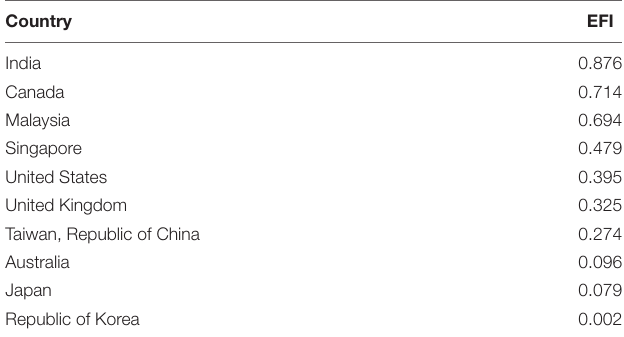
TABLE 1 | Ethnic fractionalization index (EFI) of selected countries from Yeoh (2001). Higher scores represent greater racial diversity.